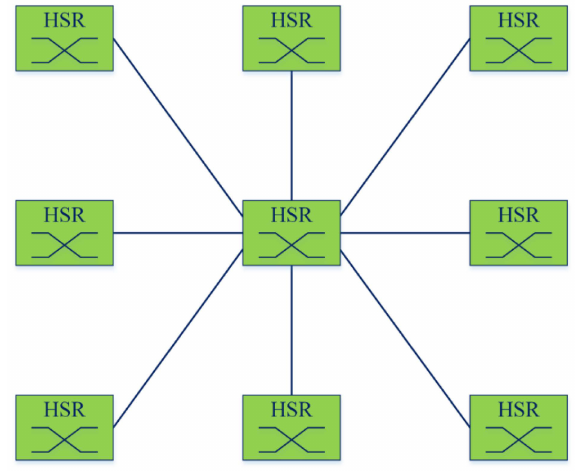
Figure 9. SwitchBox-based HSR in star topology.